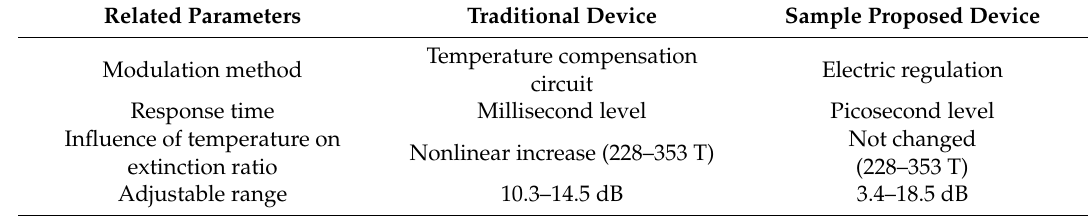
Table 2. Comparison between our device and a traditional device.